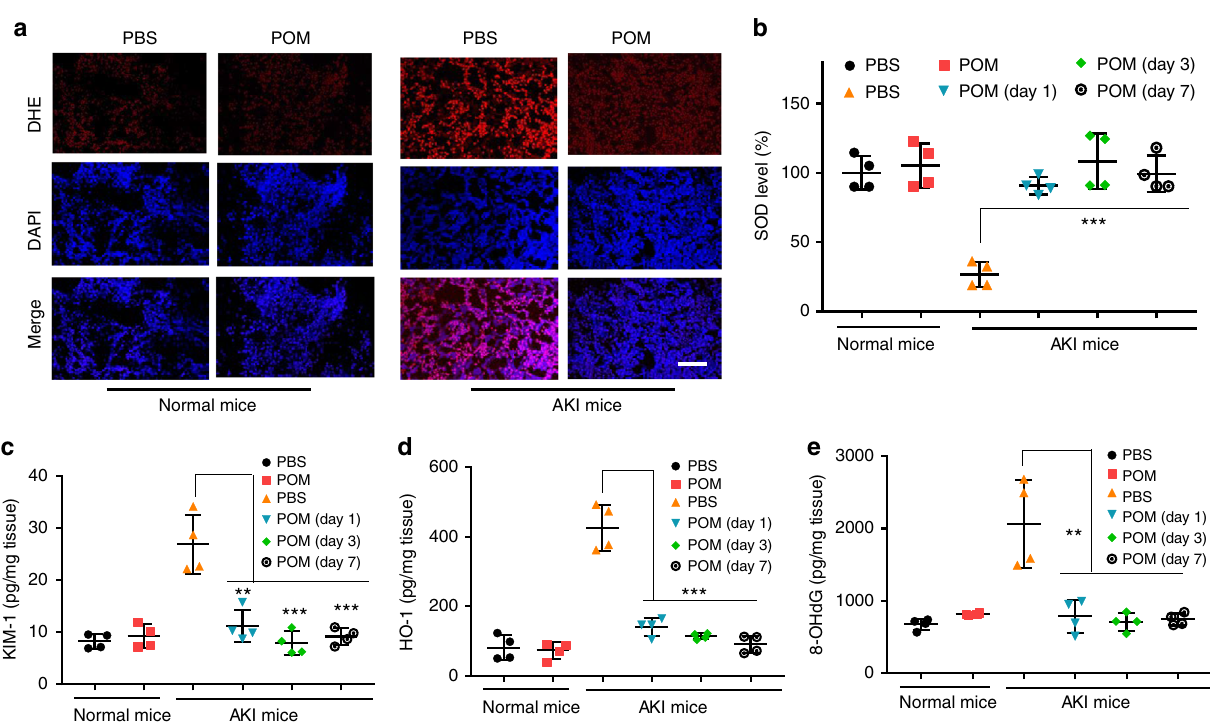
Fig. 6 Analysis of renal tissue after treatments. a Dihydroethidium (DHE) and DAPI staining of kidney tissues from each group. Scale bar: 100 µ m. SOD levels ( b ), KIM-1 ( c ), and HO-1 ( d ) measured in renal tissue homogenates from each group. e Measurement of DNA damage (8-OHdG) in renal tissue homogenates from each group. In b – e , data represent means ± s.d. from four independent replicates, and P values were calculated by two-tailed Student ’ s t -test (** P < 0.01; *** P <